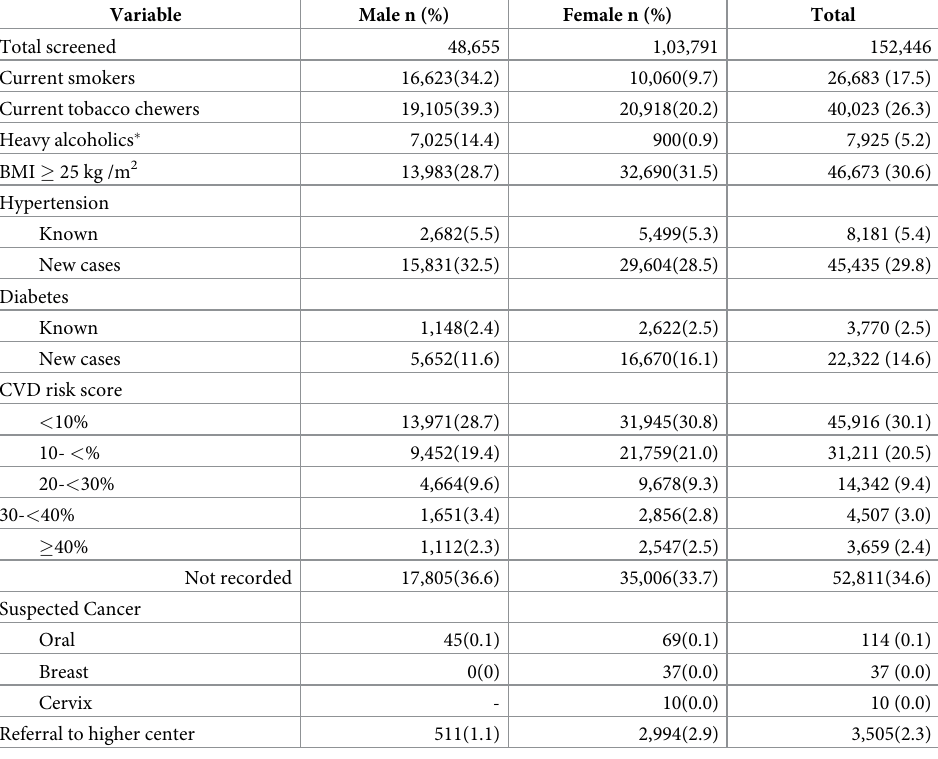
BMI: Body Mass Index; CVD: Cardiovascular Disease. PEN: Package of Essential Non communicable Disease Interventions.